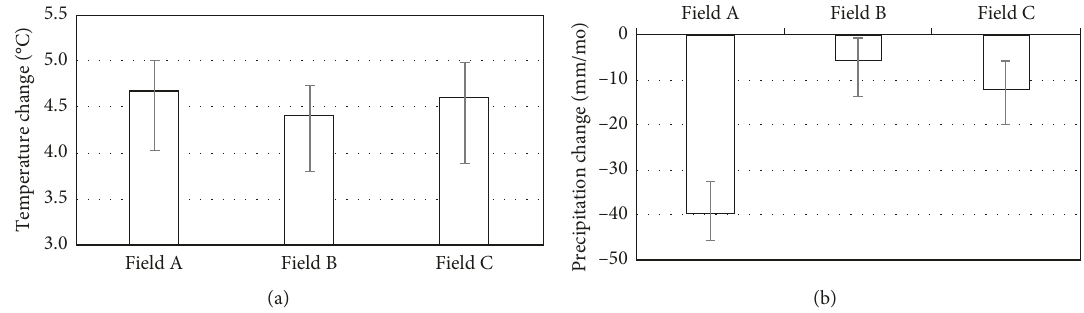
Figure 5: Projected future changes of (a) surface air temperatures and (b) precipitation for the targeted ski fields. Error bars indicate uncertainty ranges by SST